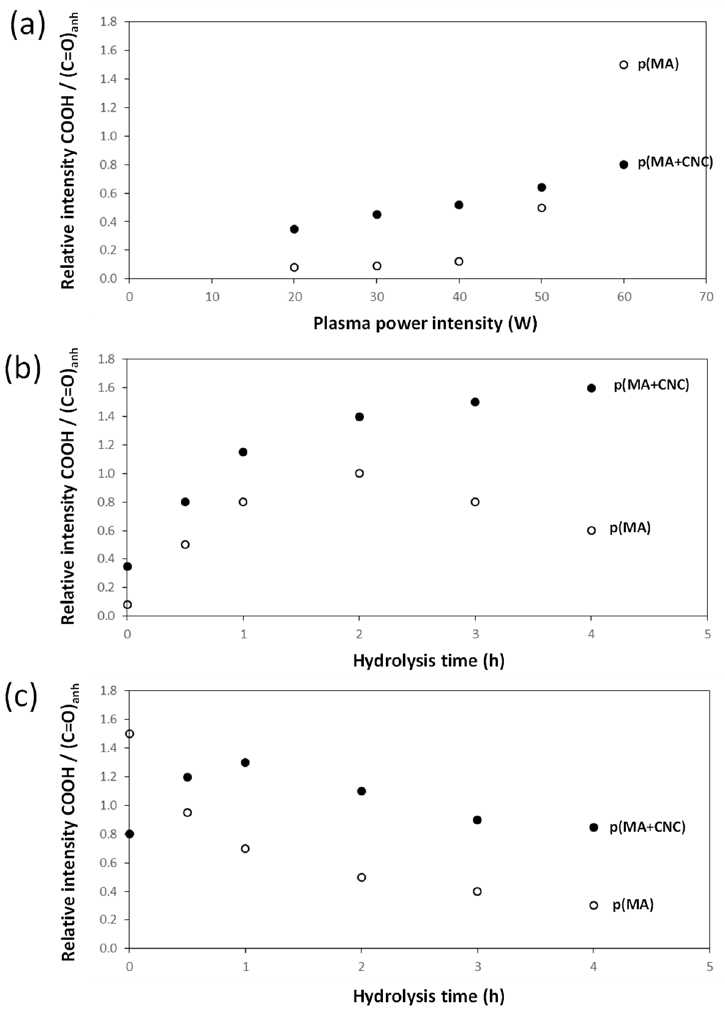
Figure 7. Evolution of chemical structure of the p(MA) films and p(MA+CNC) nanocomposite films based on FTIR analysis: ( a ) effect of plasma conditions (variable power intensity, DC = 2%); ( b ) effect of hydrolysis at 20 W, DC = 2%; ( c ) effect of hydrolysis at 60 W, DC = 2%.